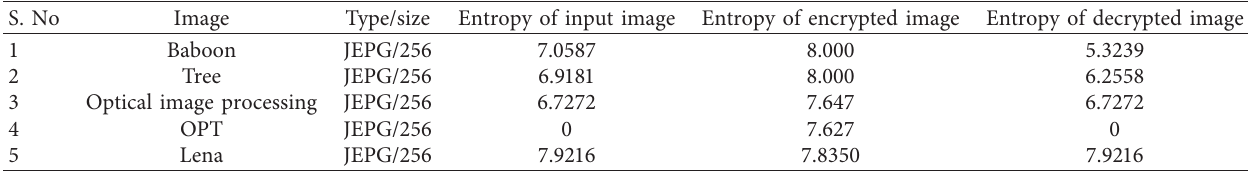
Table 2: The entropy calculations of grayscale and text images.